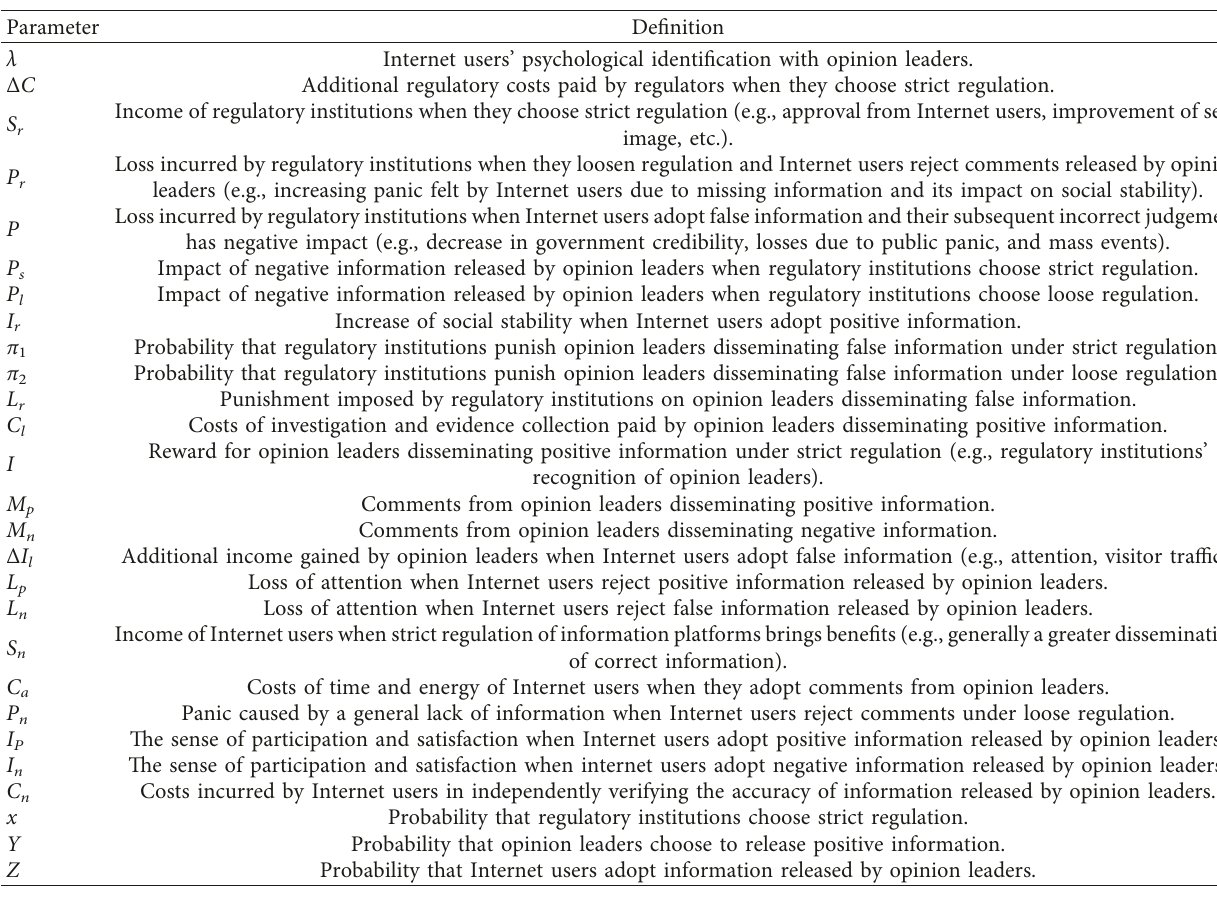
Table 1: Parameters and